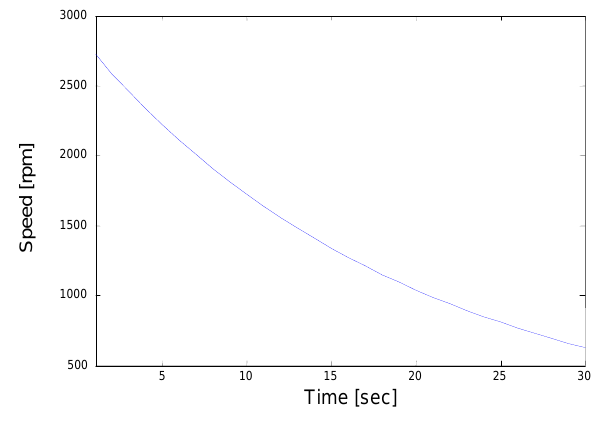
Figure 2. Simulated coast-down